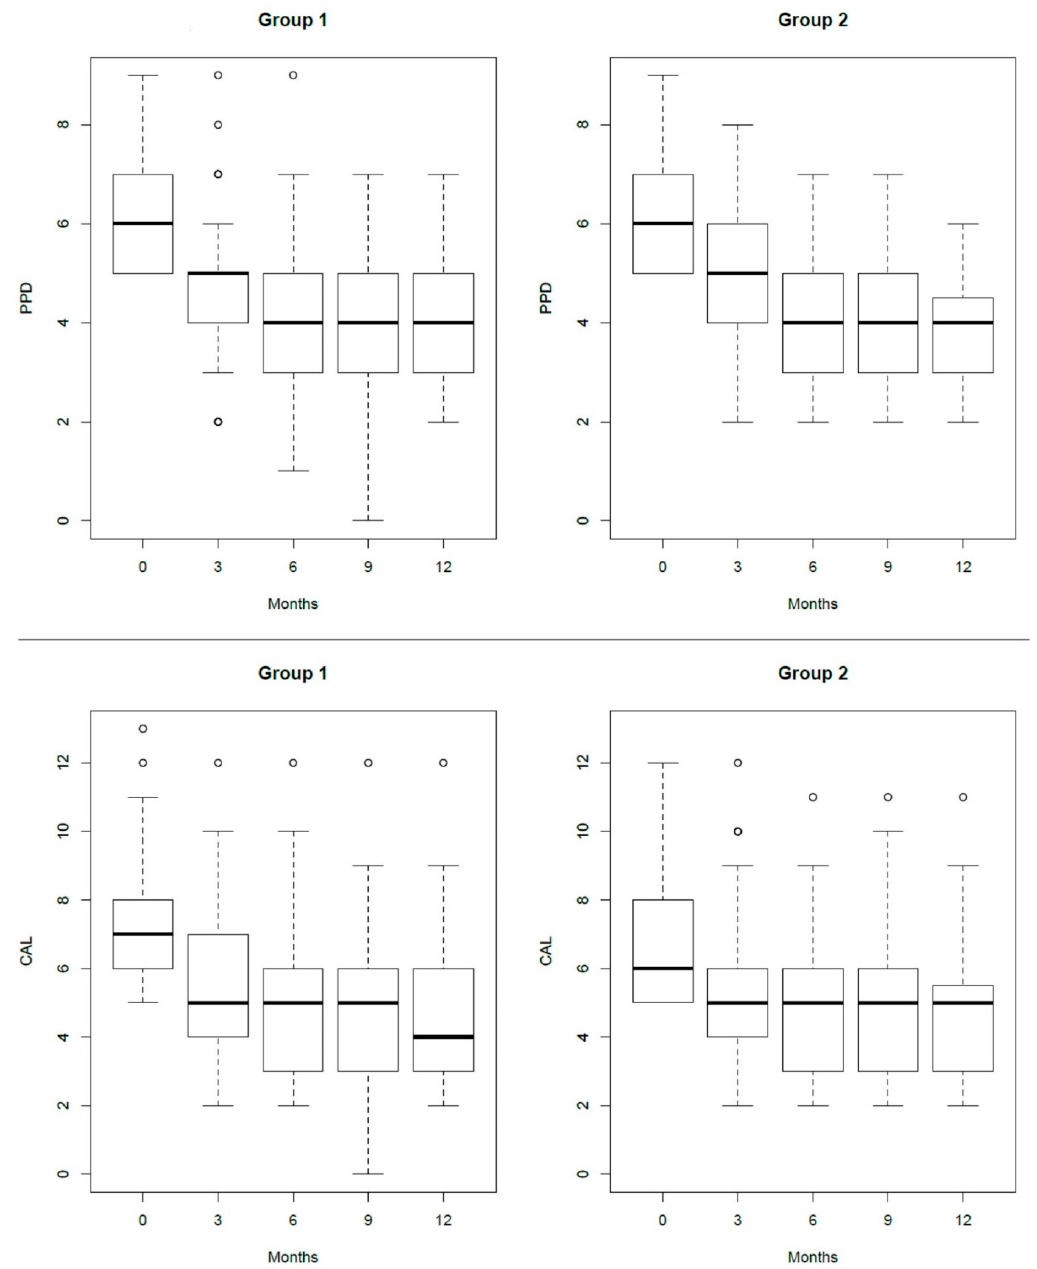
Figure 1. Box plot showing the median, interquartile range, minimum and maximum values (the square and the two extremities) and the outlier values (the circles) of PPD and CAL differences in the same group and between groups. Overall, the presence of residual pockets was reduced without any statistical differ- ences between groups from 3 months to 12 months, 22.6 to 14.8% for HA group vs. 29.7 to 7.9% for the placebo group. In both groups, the reduction from one time point to the other was not significant.